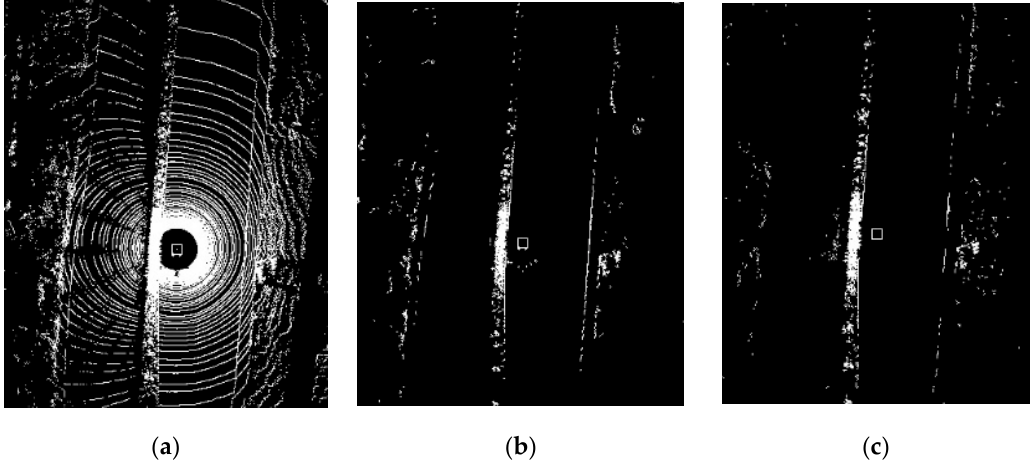
Figure 19. Comparison of the ground segmentation method used in [23] and the proposed method. ( a ) Original point cloud map; ( b ) Result of the method used in [23]; ( c ) Result of the proposed method.